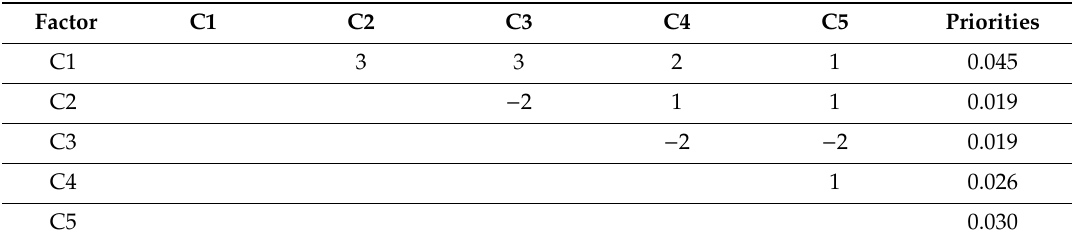
Table 7. Compare the relative importance with respect to social criterion (C).